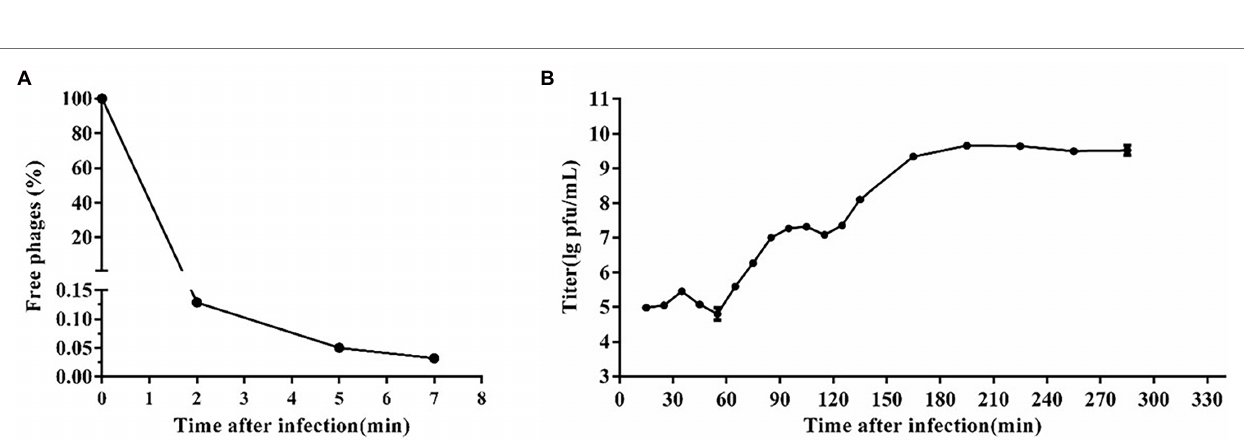
FIGURE 2 | One-step growth curve of phage SA1. (A) Adsorption curve of phage SA1. Free phage (%) = the number of free phages after infection/the number of free phages without infection. After incubation for 5 min, free phages accounted for only 0.05% of phages in total. (B) One-step growth curve of phage SA1 after incubation for 5 min. The data are expressed as means ± SD ( n =